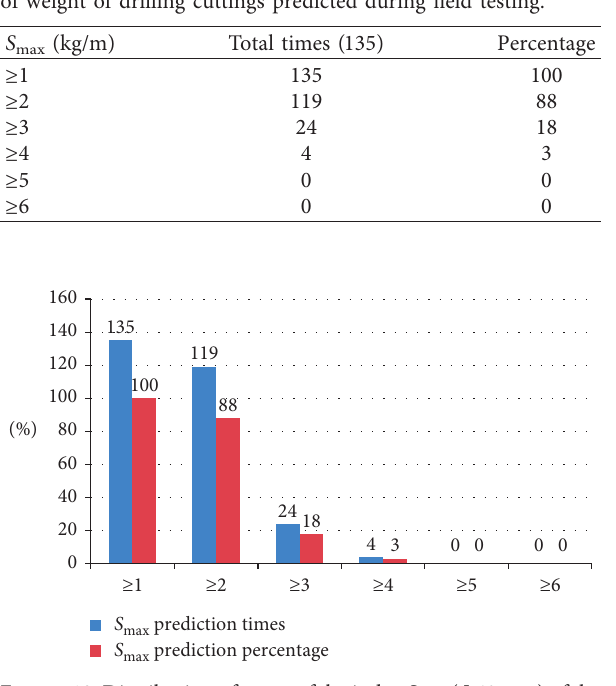
max ( Φ 42mm) of the